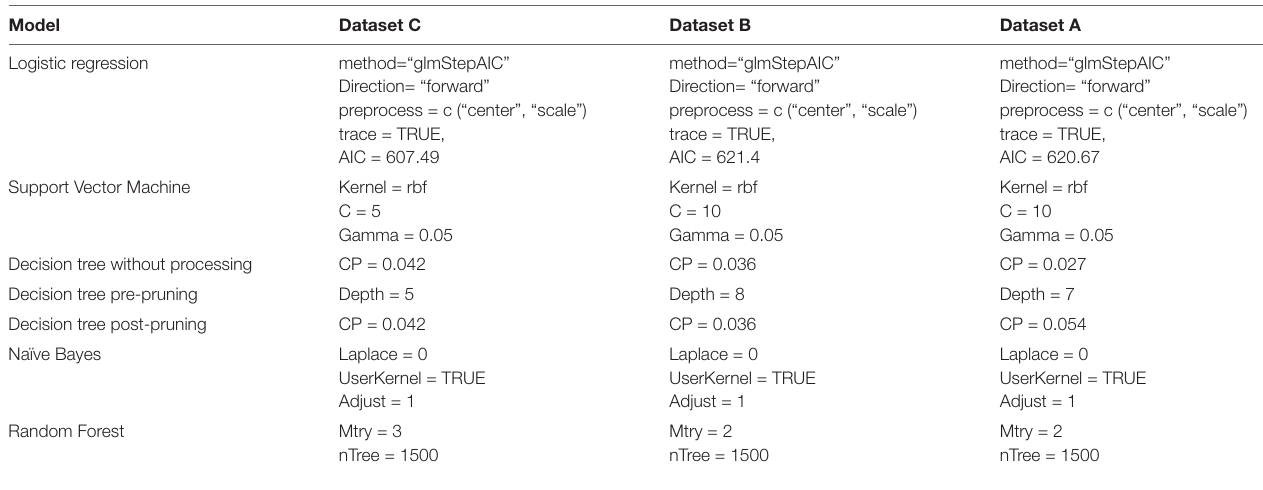
TABLE 2 | Machine learning parameters and commands for execution.